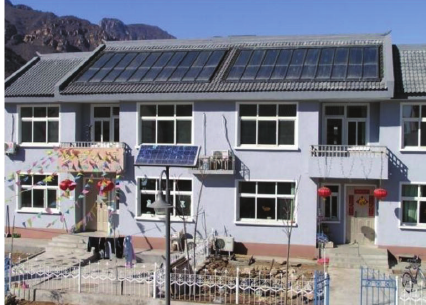
Figure 2: Flat plate solar collectors integrated with slope roof for solar space heating system in